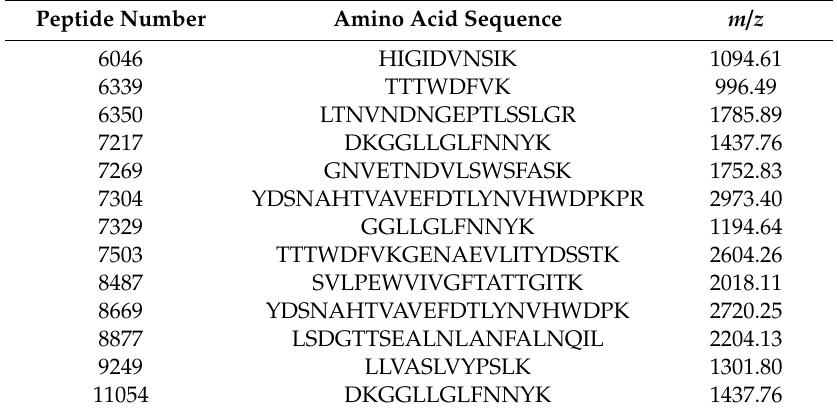
Table 2. The peptide of the Zihua snap bean lectin as determined by Nano LC-ESI-MS / MS.